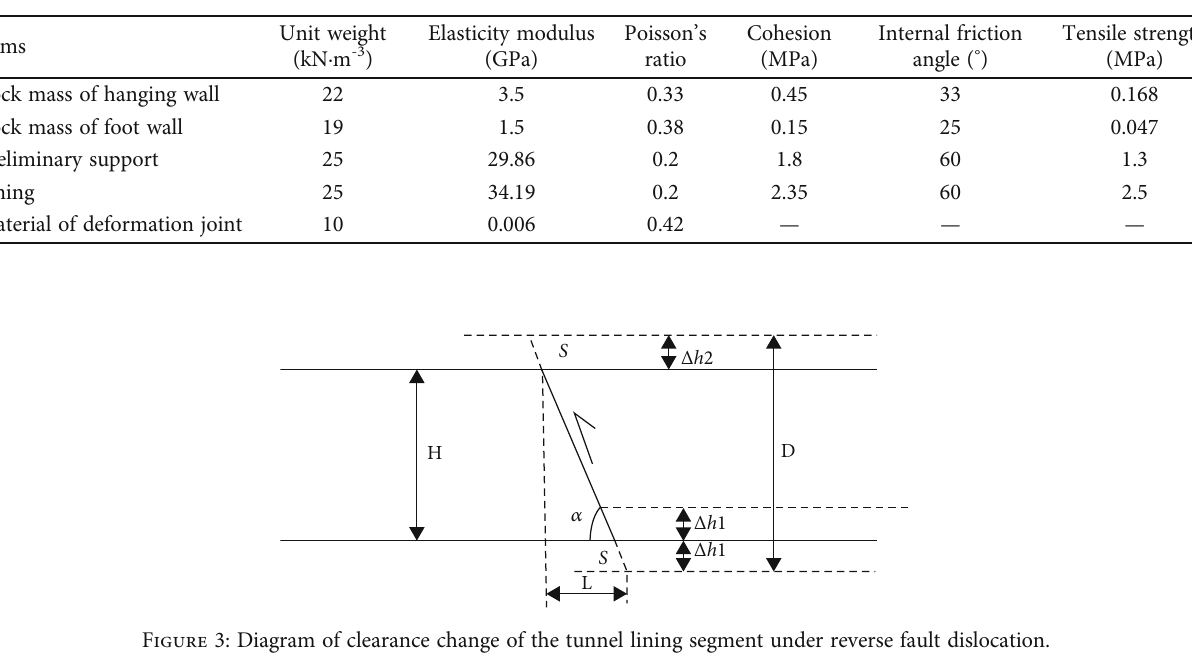
Table 2: Equivalent physical and mechanical indexes adopted in the numerical model.